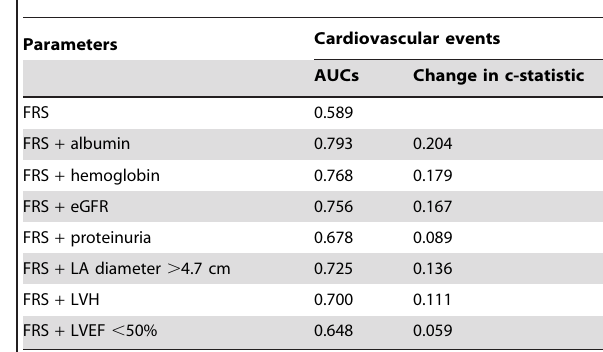
Table 4. Prognostic value of biomarkers and echocardiographic parameters for cardiovascular events using c-statistic and ROC curve analysis with calculated